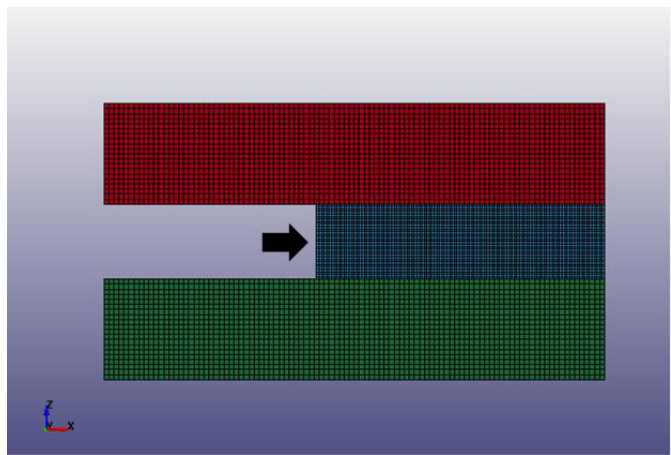
Figure 17. Establishment of a two-dimensional coal and rock mass model including a roadway.